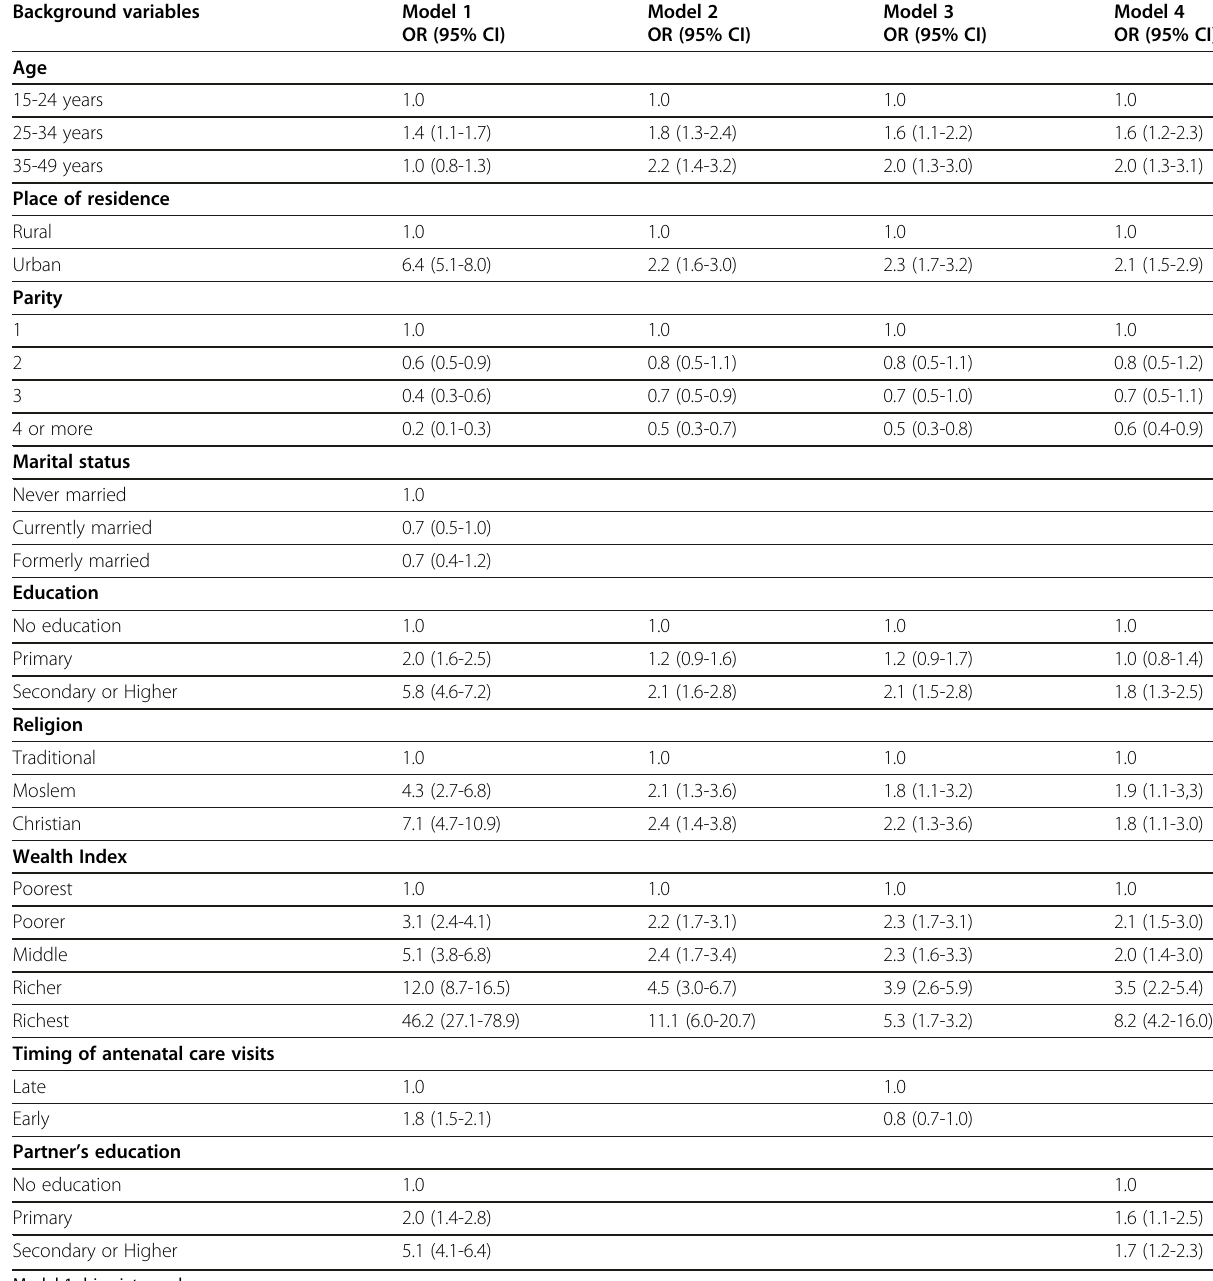
Table 3 Odds ratios (OR) and 95% confidence intervals (CI) for factors associated with delivery assisted by trained personnel among Ghanaian women in